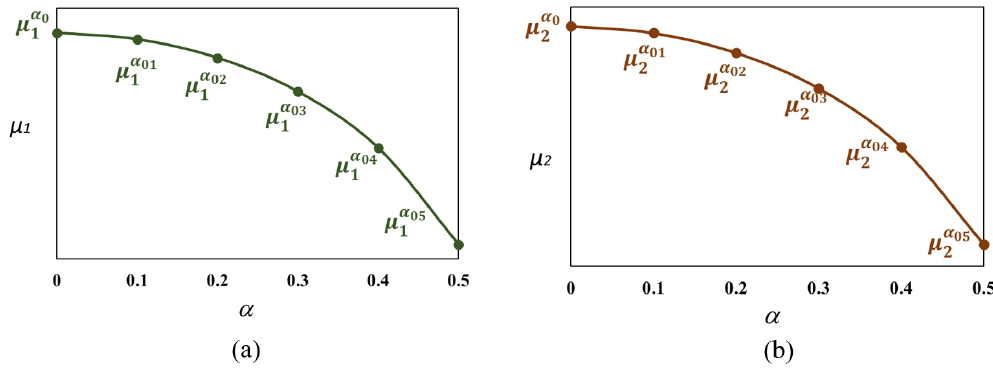
Figure 9. Schemes of the graphs α vs. µ 1 ( a ) and α vs. µ 2 ( b ).